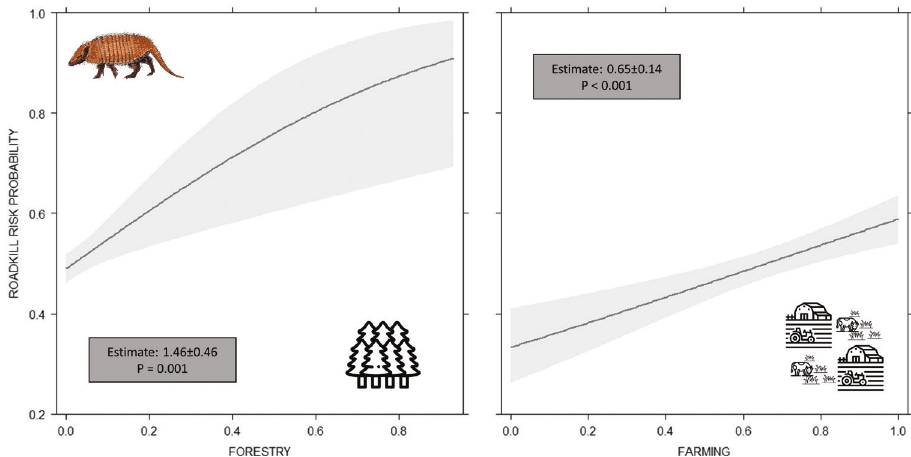
Figure 5. Best model selected by AIC for E. sexcinctus and its estimated coefficients. For the six-banded armadillo the best model represents forestry and farming positively related to roadkill risk, showing that the roadkill of this species is related to human modified